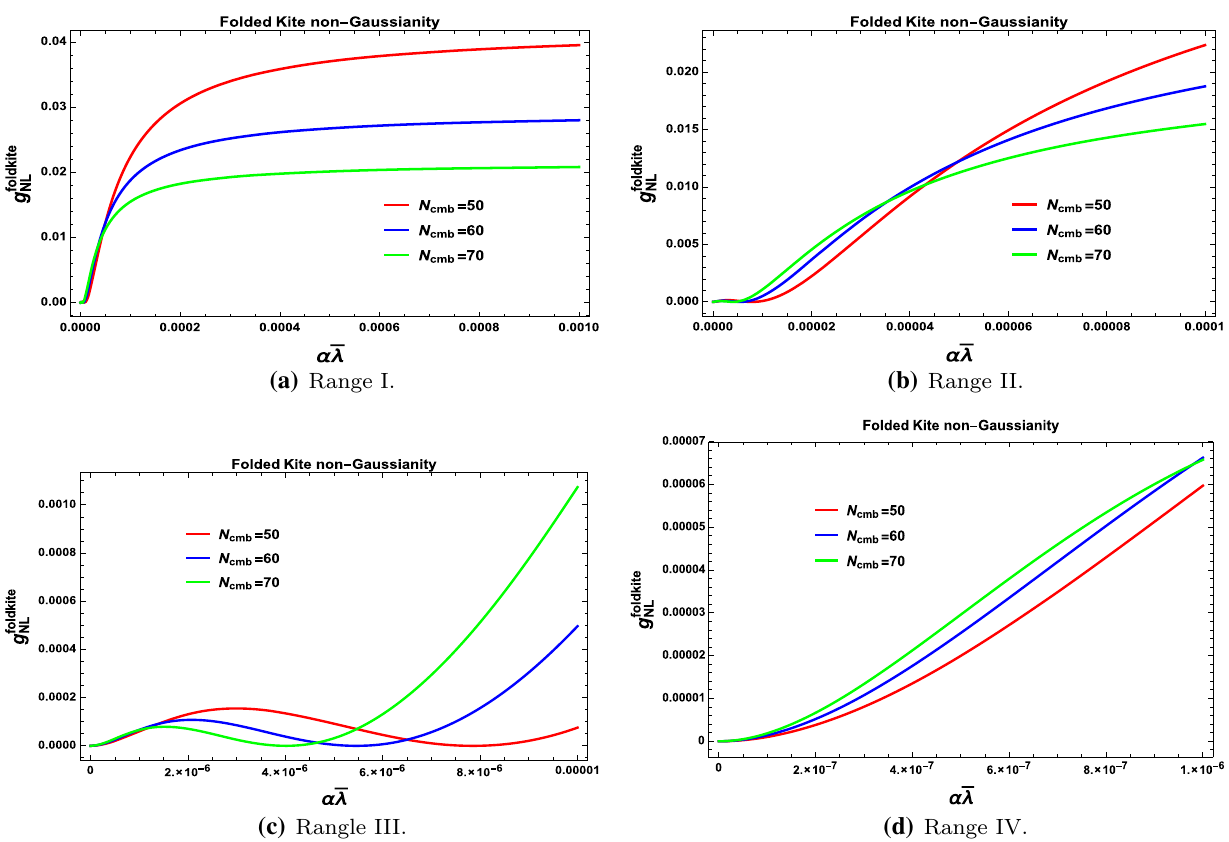
Fig. 28 Representative diagram for equilateral non-Gaussian three point amplitude vs. product of the parameters α ¯ λ in four different regions for = 50 ( red ), N = 60 ( blue ) and N = 70 ( green ) N cmb cmb cmb